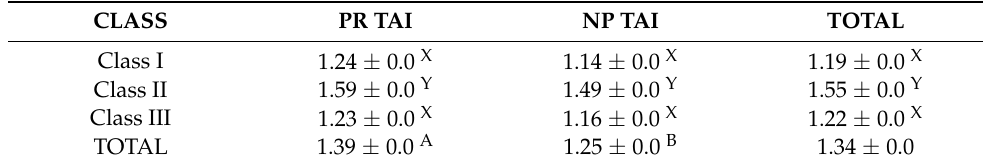
Table 3. Area of the dominant follicle recorded on the day of TAI in pregnant and non-pregnant buffaloes with different days in milk (Class I: <90 DIM; Class II: 91-150 DIM; Class III: >151 DIM).